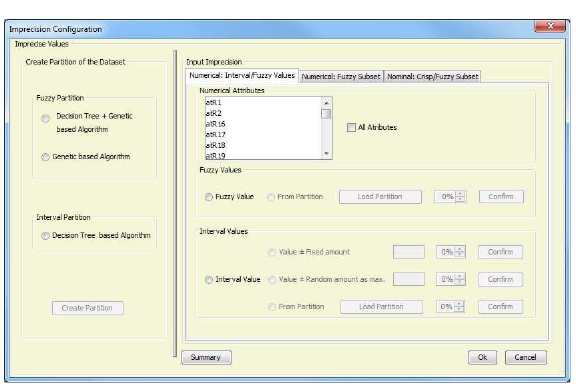
Fig. 6. Adding Low Quality Data